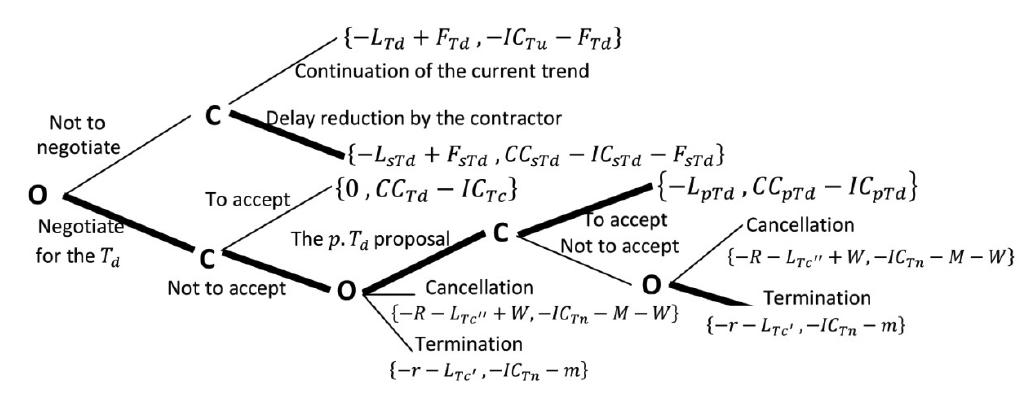
Fig. 6. Game tree for form